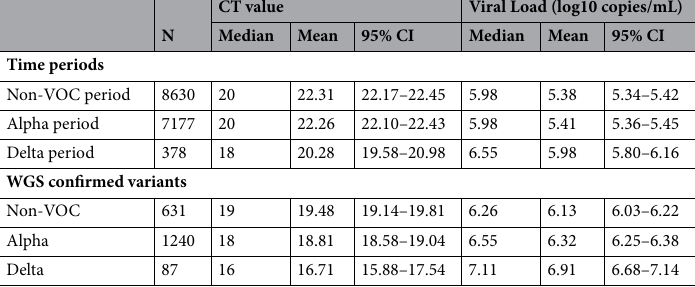
CT value Viral Load (log10 N